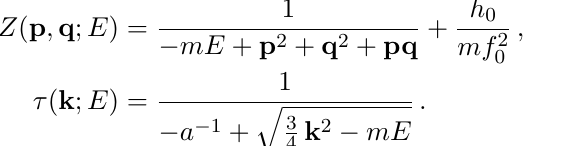
Figure 4 . Typical diagrams contributing to the particle-dimer scattering. The double line denotes the dimer, the single line | the particle, and the (cid:12)lled boxes stand for the dimer-two-particle vertex. Here, E denotes the total CM energy of three particles, a denotes the S-wave scattering length,